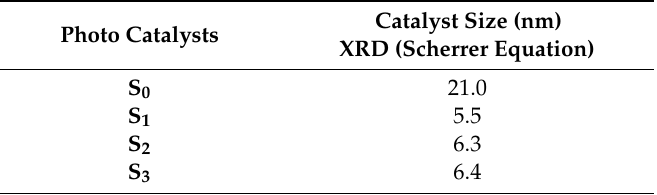
Table 1. Summary of the average particle sizes of TiO 2 Degussa and the synthesised C–N–TiO 2 photo catalysts estimated from XRD analysis using the Scherer